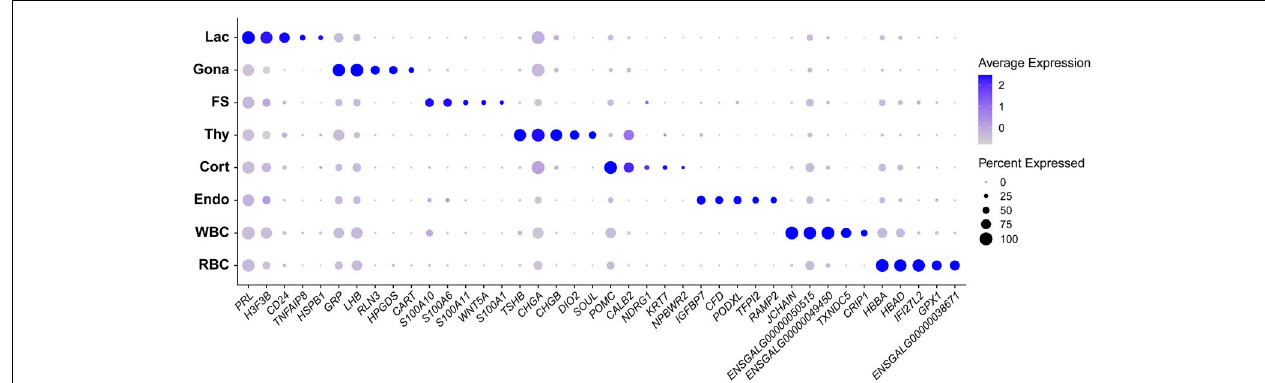
FIGURE 2 | Dot plot showing the expression pattern and level of some established marker genes (shown in columns) for each major cell type (shown in rows) in chicken anterior pituitaries. Color intensities show the expression level of the indicated